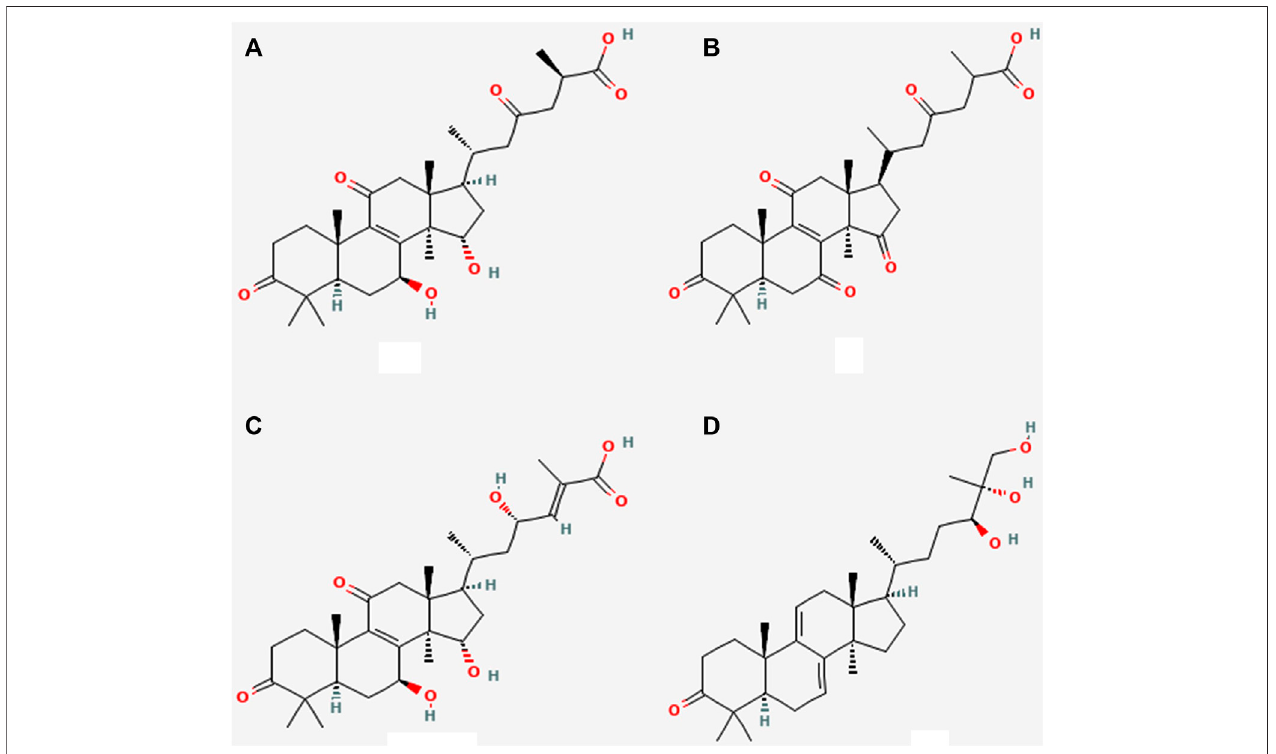
FIGURE 1 | Various triterpenoids derivatives (A) Ganoderic acid A300 (B) Ganoderic acid E300 (C) Ganoderic acid gamma 300 (D) Ganodermanontriol 300.